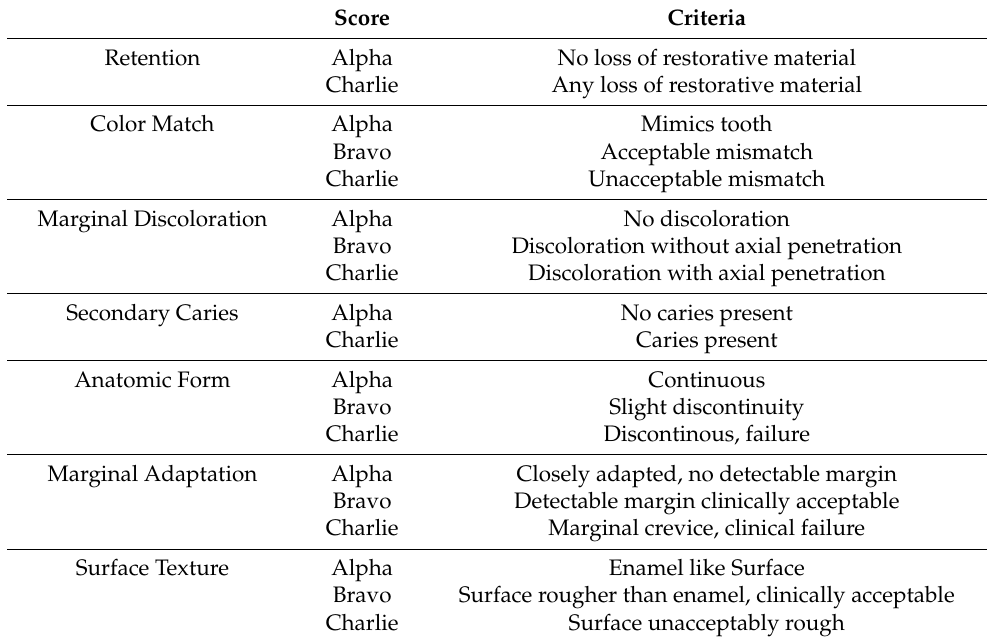
Table 1. Modified USPHS